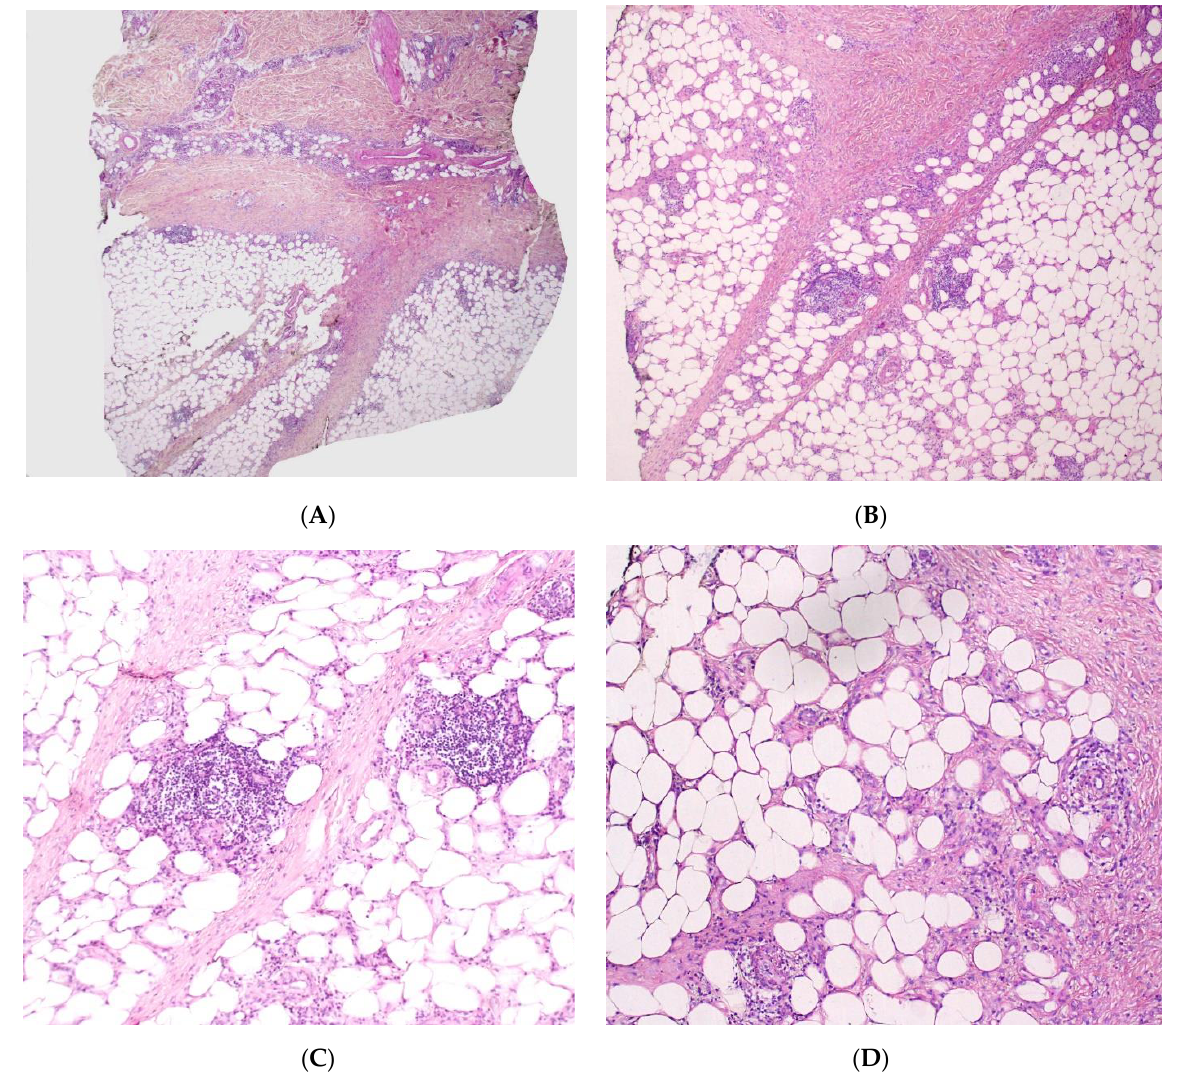
Figure 9. Lupus panniculitis. ( A ) Dense dermal infiltrate with extension into subcutaneous fat (original magnification × 30). ( B ) Septae appear fibrotic (original magnification × 100). ( C ) Lymphoid follicles (original magnification × 120). ( D ) Necrosis of adipocytes with hyalinisation of the fat lobular panniculitis with lymphocytes among necrotic adipocytes (original magnification ×